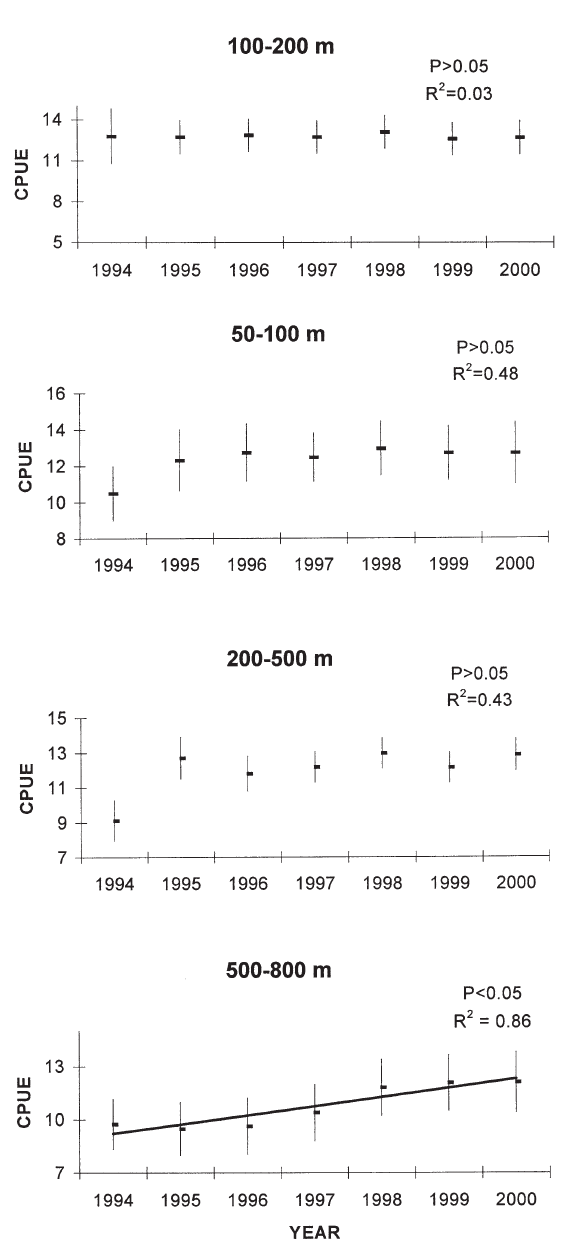
F IG . 7. – Standardised CPUE estimates expressed in ln (g/km 2 ) by year and depth stratum for all MEDITS fish species. Vertical lines indicate the 95% confidence intervals of the corresponding estimates. Trend-lines indicate the presence of significant